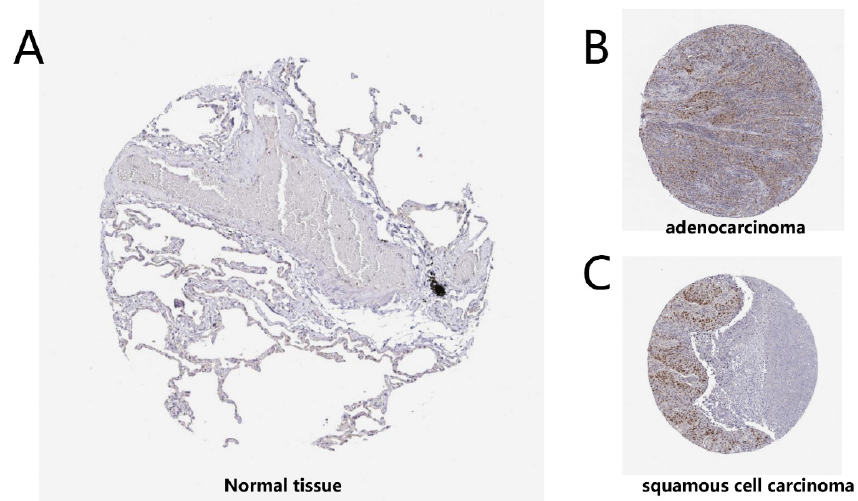
Figure 3. Immunohistochemical analysis of the Timeless gene in the Human Protein Atlas database.